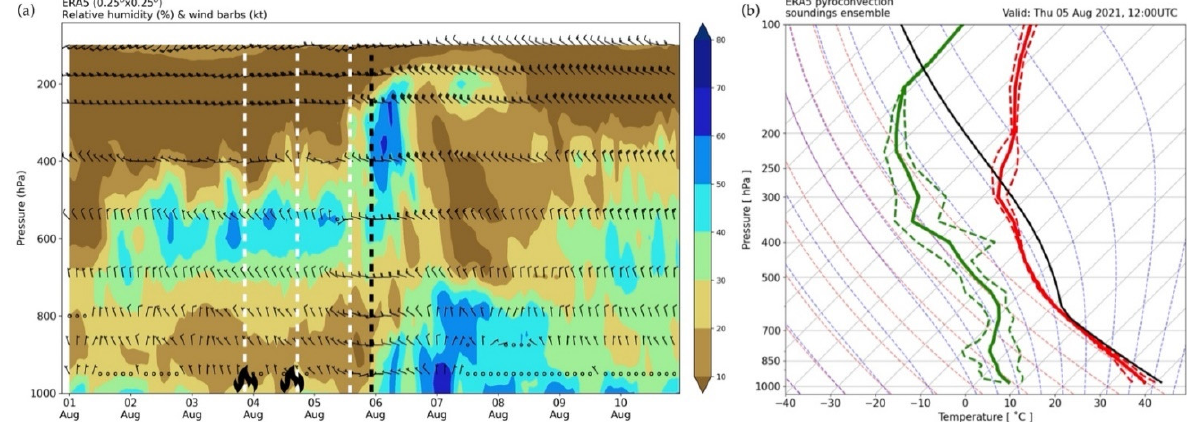
Figure 7. ( a ) Time-pressure plot of ERA5 relative humidity (shaded) and horizontal wind (barbs) averaged over the examined wildfires. The ignitions of the wildfires are denoted with black flame icons. The black dashed line indicates the approximate arrival time of the upper-level trough. The white dashed lines denote approximately the occurrence of the most widespread and active pyroconvection in multiple locations. ( b ) Vertical profile of temperature (red) and dew point (green) averaged over the ERA5 grid points closest to each ignition location. Dashed lines indicate maximum and minimum values across the five wildfires. The solid black line corresponds to the most unstable air parcel profile.